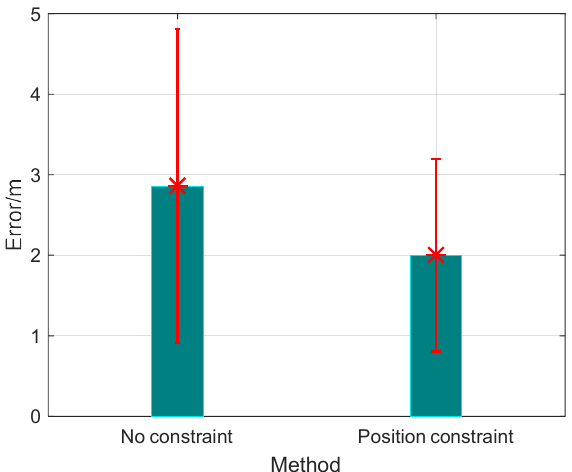
Figure 10. The effect of position constraint on positioning. Figure 10. The e ff ect of position constraint on